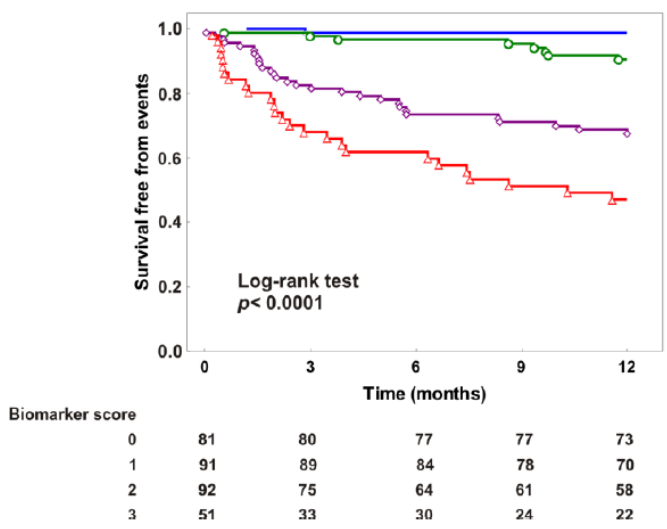
Figure 2. Kaplan-Meier curves according to the number of altered biomarkers are shown.